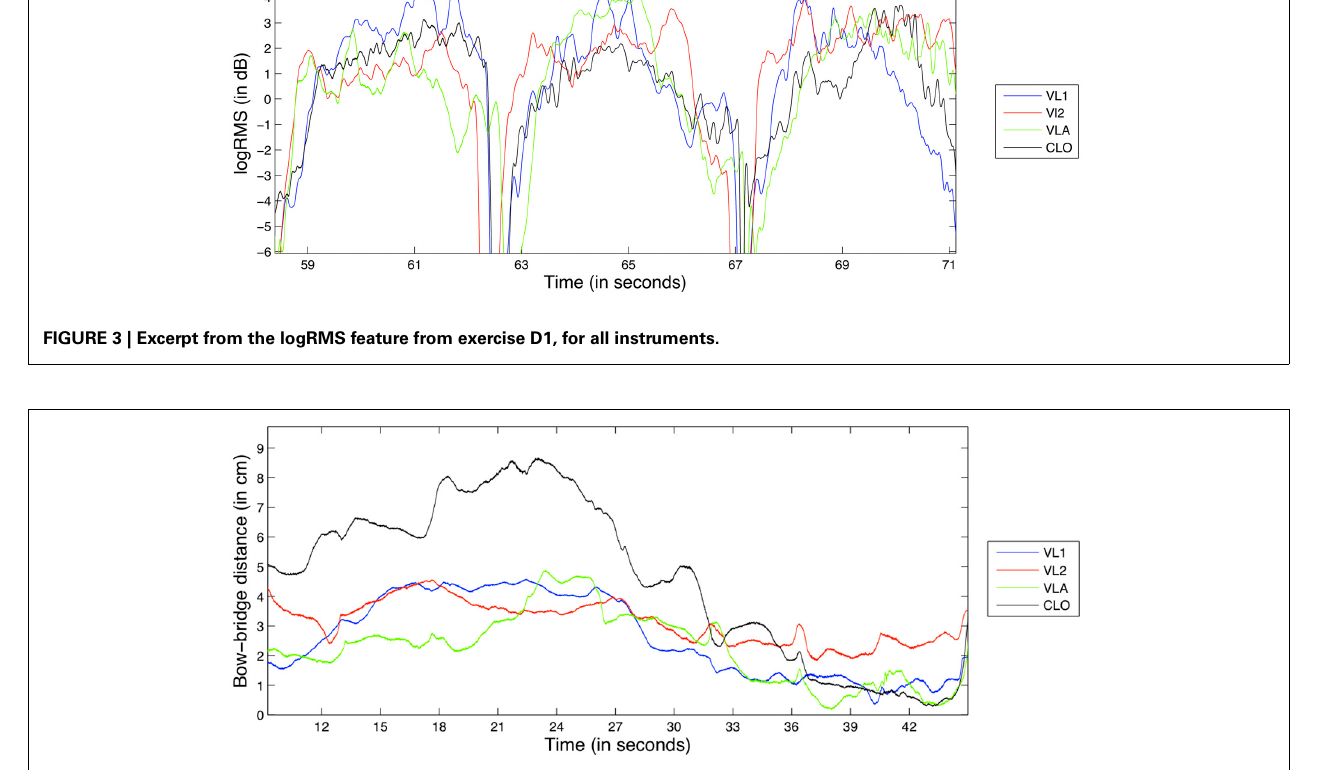
FIGURE 4 | Excerpt from the bow-bridge distance feature from exercise D1, for all